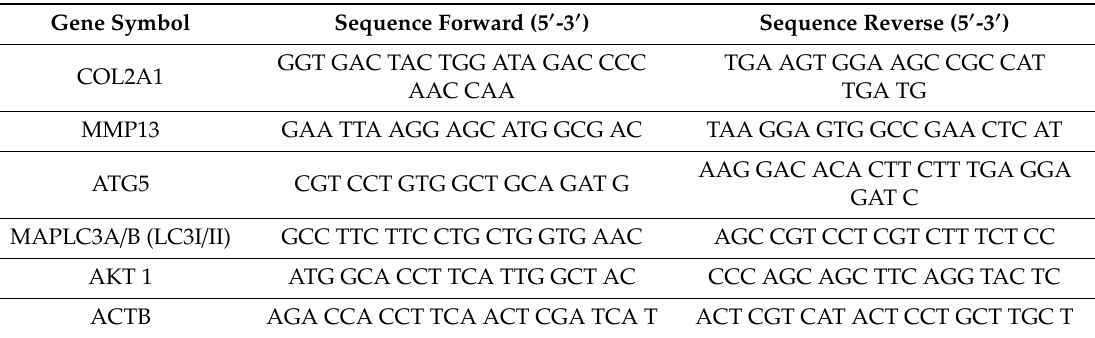
Table 2. Primers used to analyze gene expression in rabbit chondrocytes. Gene